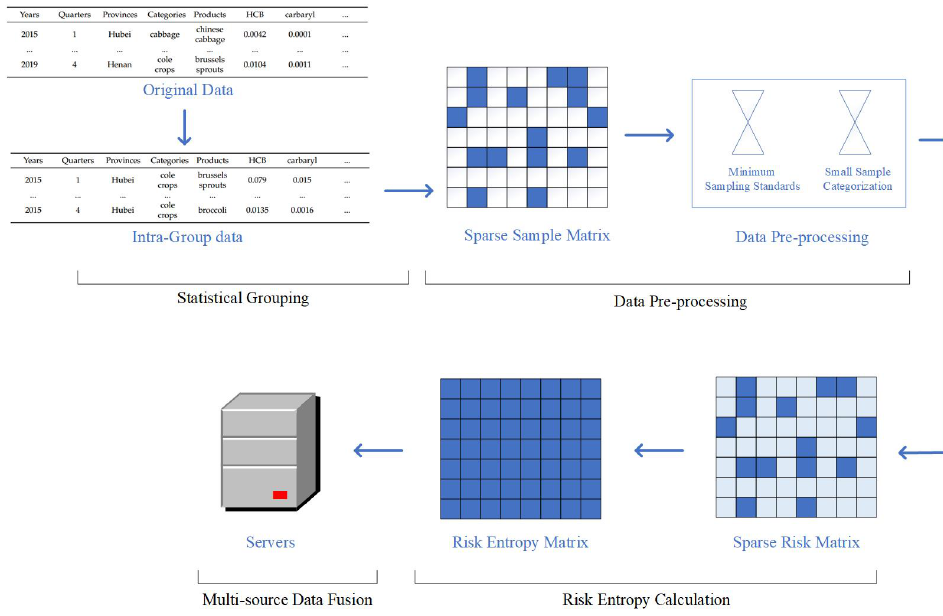
Figure 3. Workflow of risk